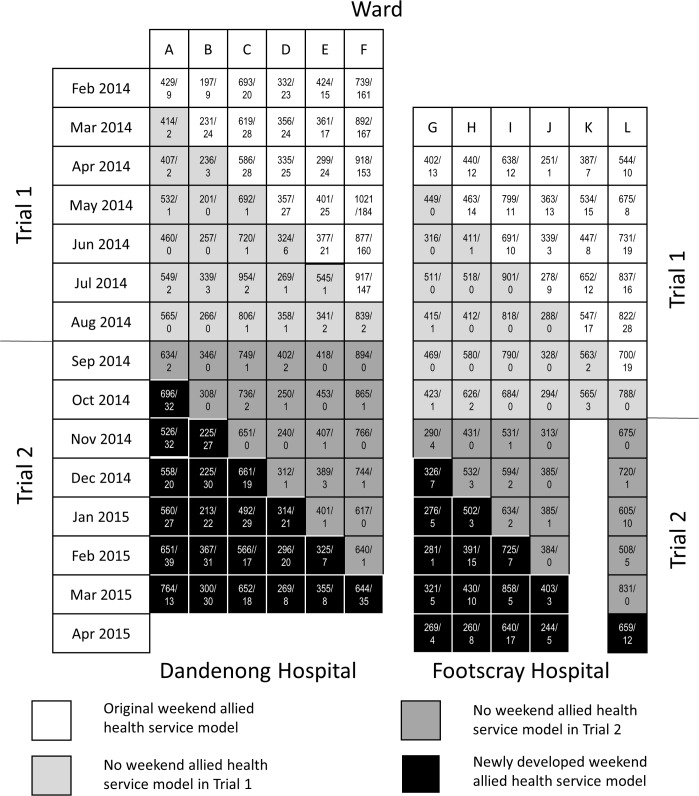
Trial design and occasions of allied health service delivery on weekdays and weekends within each month of the trial.Numbers in boxes indicate occasions of service provided by allied health team on weekdays/on weekends that month. These data include approved clinical exceptions during no weekend service periods.